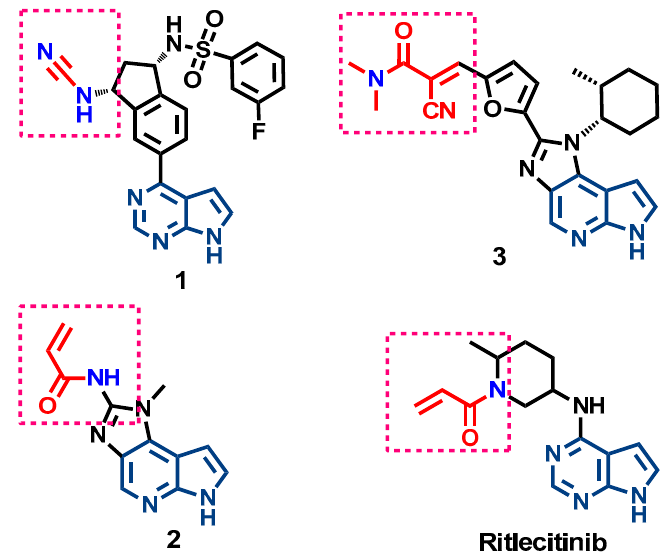
Figure 6. JAK3 covalent inhibitors.